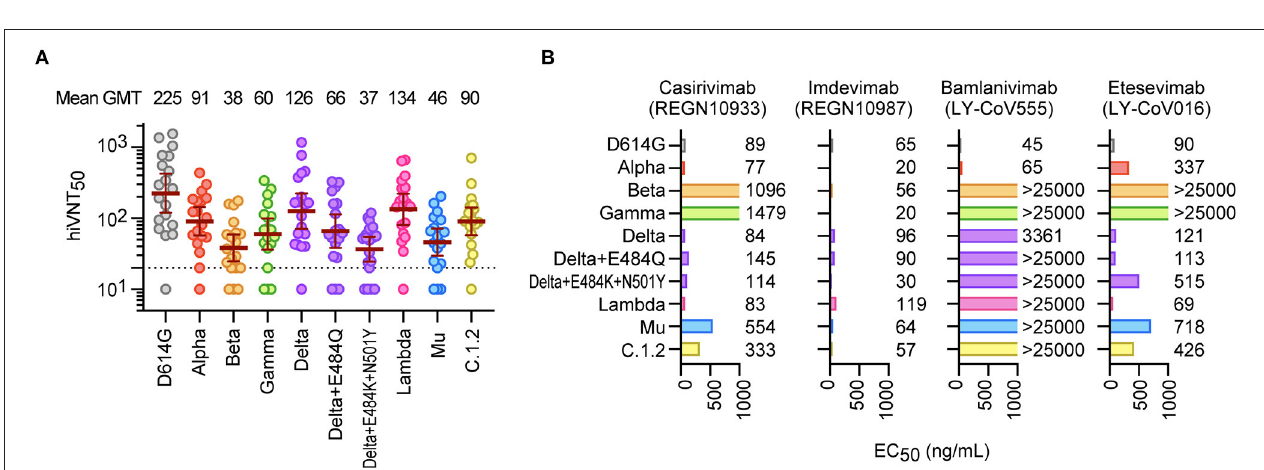
FIGURE 1 | Identification of vaccine-escape variants. (A) Flow of this research. Spike haplotype analysis was used to search for mutants with specific mutations, and those with high growth rates were extracted and tested for neutralization. (B) Neutralizing activity of Pvac19 sera panel ( n = 19, 1 week after the second dose) against each variant, calculated via a rapid neutralization test (qualitative hiVNT). The percentage of inhibition of viral infection by 20-fold dilution of serum is shown as the hiVNT score in the scatter plot. The mean of two independent determinations is plotted. The brown lines indicate the mean hiVNT scores, the values of which are displayed above the graph.